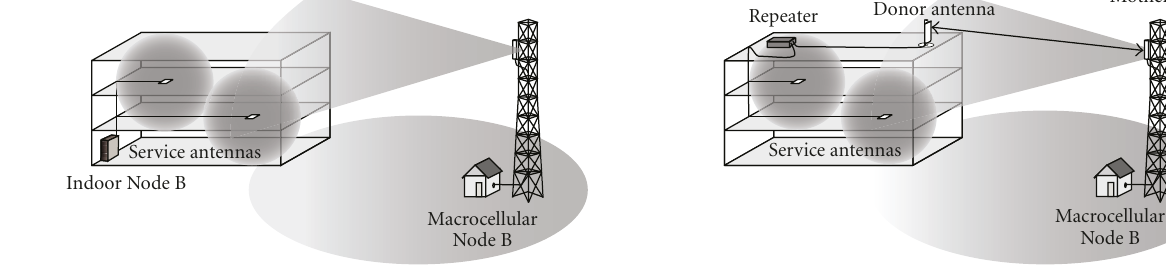
Figure 2: Outdoor-to-indoor